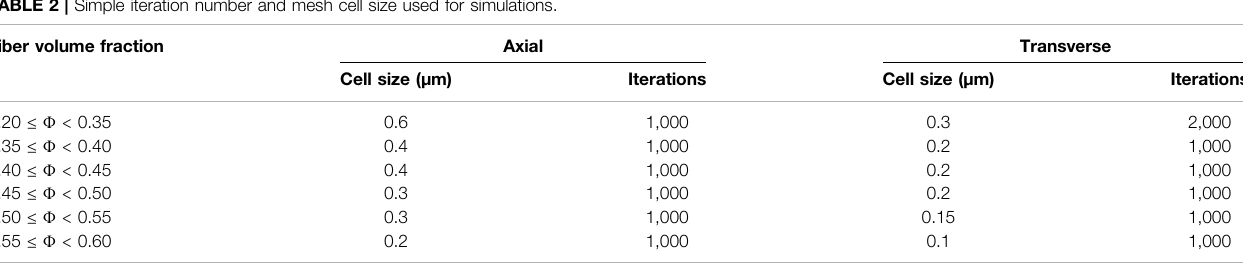
TABLE 2 | Simple iteration number and mesh cell size used for